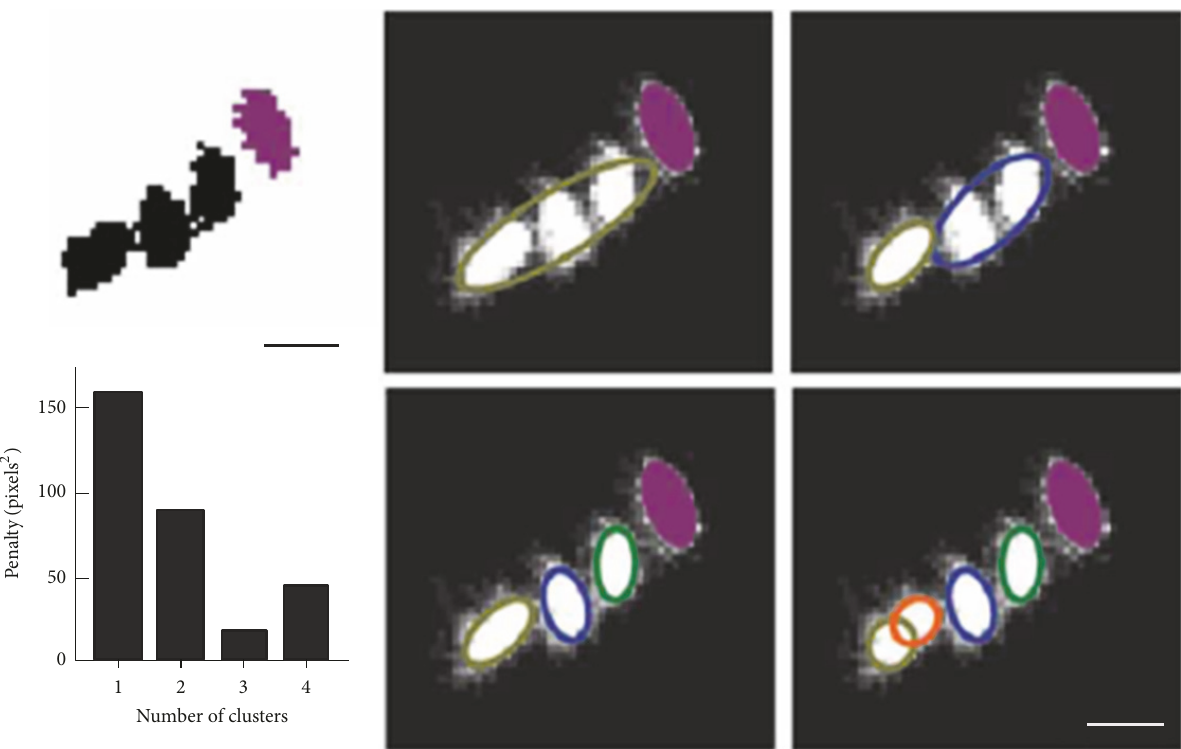
Figure 3: Procedure of extracting individuals from occlusions using clustering and ellipse fitting [20].